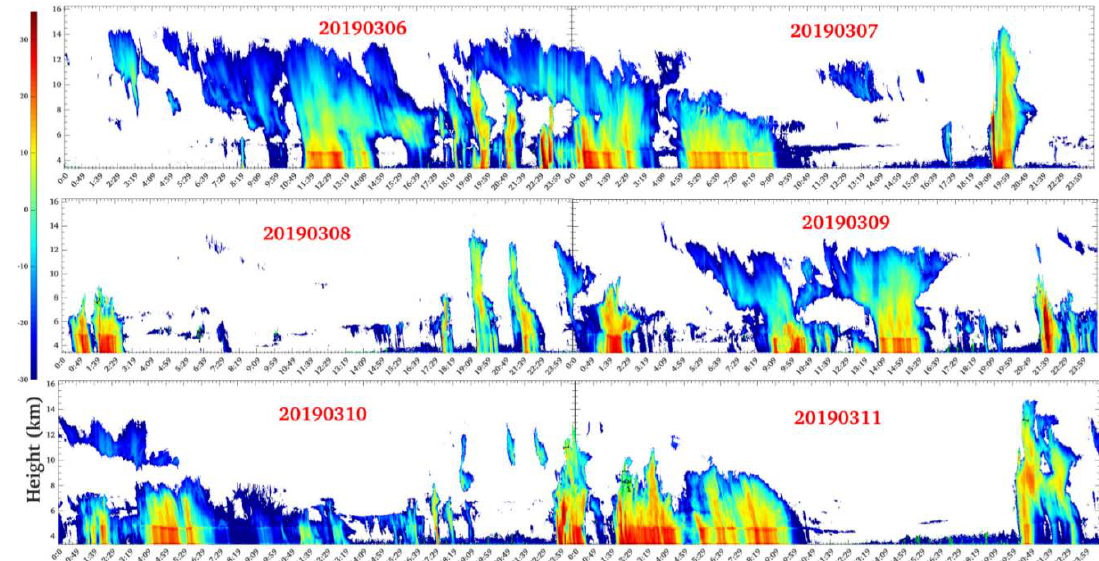
Figure 9. Vertical temperature profiles during rainy periods recorded by radiosonde launches in 6 March to 11 March at the site of the Huancayo. Representative moist and dry adiabatic lapse rates are indicated by the long and short-dashed lines, respectively.